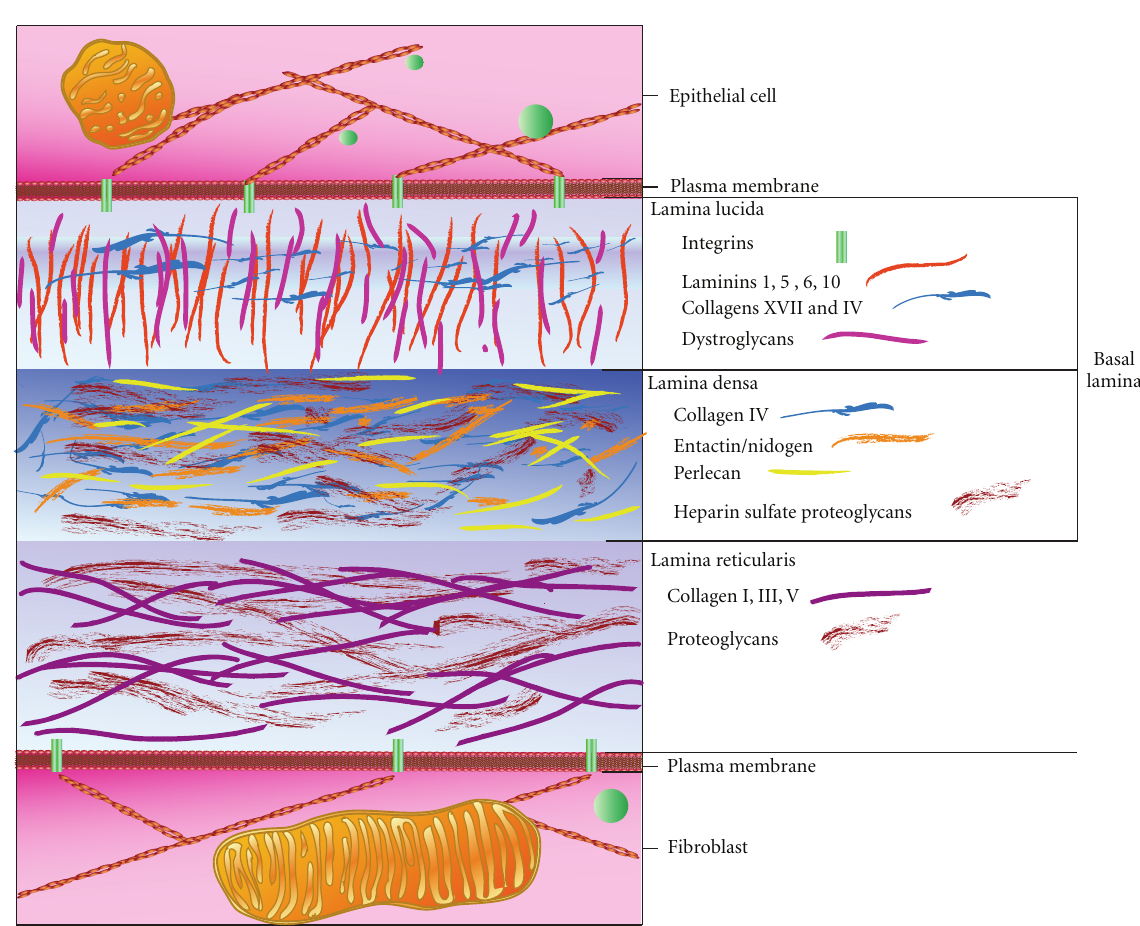
Figure 3: Basement membrane. The basement membrane underlies the typical cellular epithelium or vascular endothelium and consists of two thin structural layers. One layer is the basal lamina made by epithelial or endothelial cells. The second layer is the reticular lamina made by fibroblasts. Electron microscope data show that the basal lamina consists of a clear lamina lucida next to epithelial cells and an opaque lamina densa. The lamina lucida contains integrins, laminins (1, 5, 6 and 10), and collagen XVII, as well as type IV collagen, and dystroglycans. The lamina densa contains type IV collagen fibers, entactin/nidogen-1, perlecan, and heparan sulfate proteoglycans. The reticular lamina contains collagens I, III, and V and various proteoglycans. Invasion through the basement membrane requires the expression of many di ff erent cell surface adhesion receptors and matrix degrading